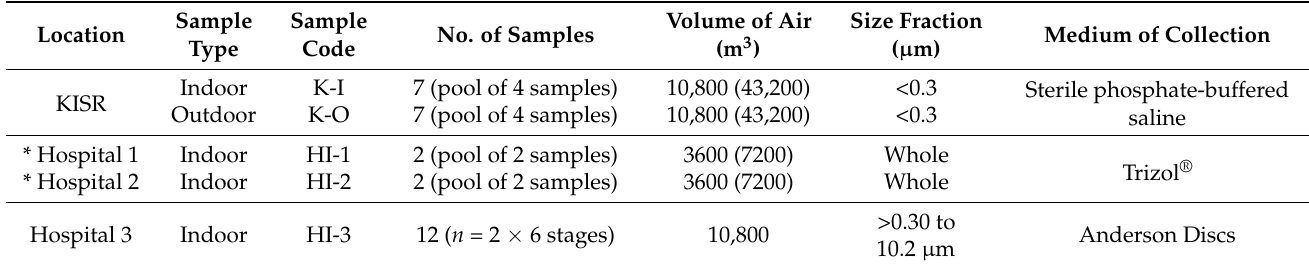
Table 2. Sampling locations and types of samples collected for ARG